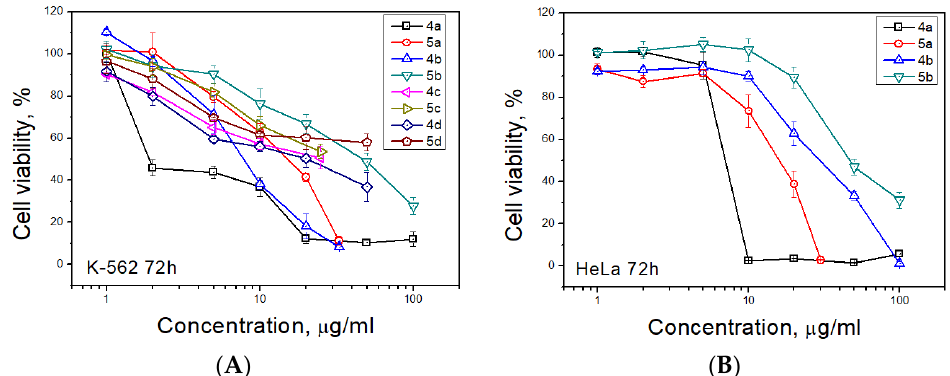
Figure 2. Antiproliferative activity of spiro-fused pyrrolo[3,4- a ]pyrrolizines and tryptanthrines against K562 ( A ) and HeLa ( B ) cell lines for 72 h. Table 2. IC 50 values ( μ g/mL) of screened compounds for K562 and HeLa cell line.